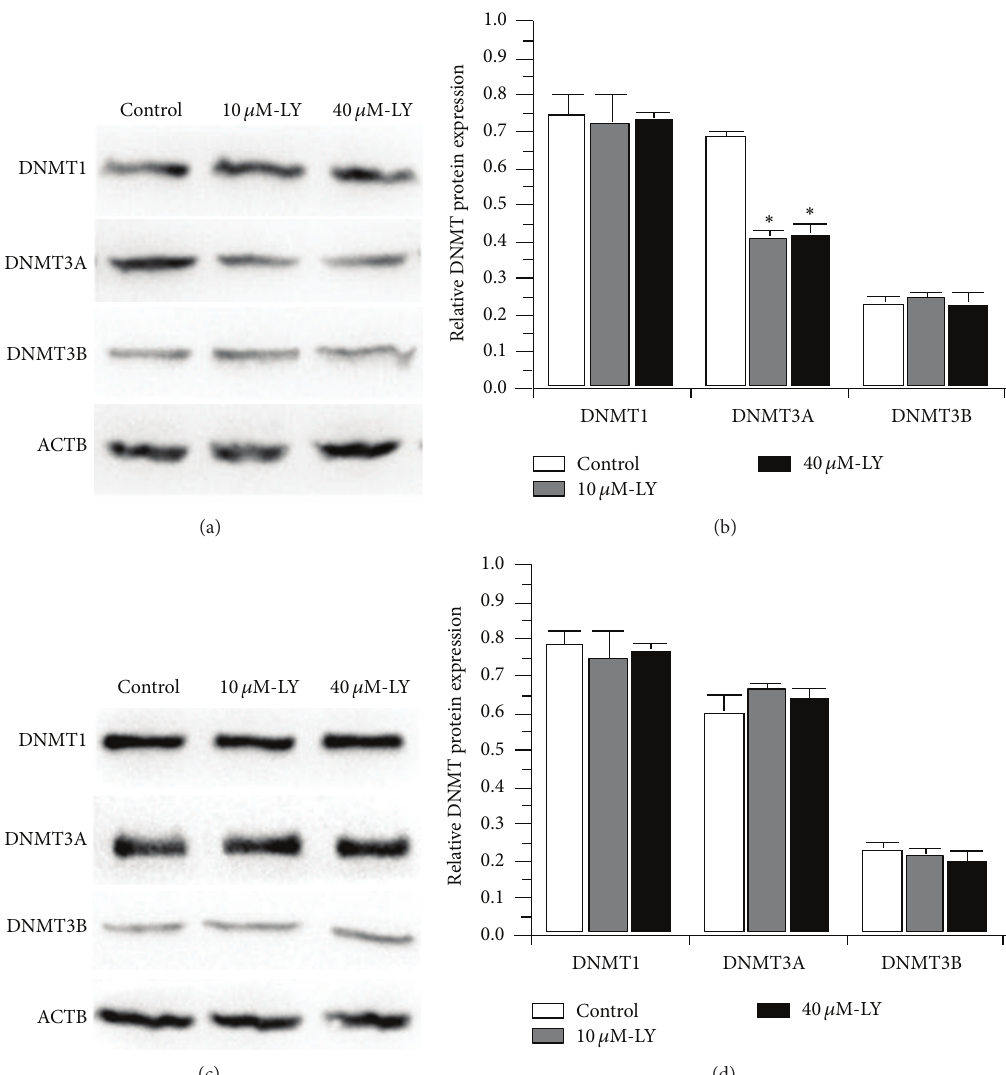
Figure 3: Western blot analysis protein expression of DNMT1, DNMT3A, and DNMT3B in PC-3 ((a) and (b)) and LNCaP cell lines ((c) and (d)) induced by 10 𝜇 M and 40 𝜇 M lycopene. LY, lycopene.